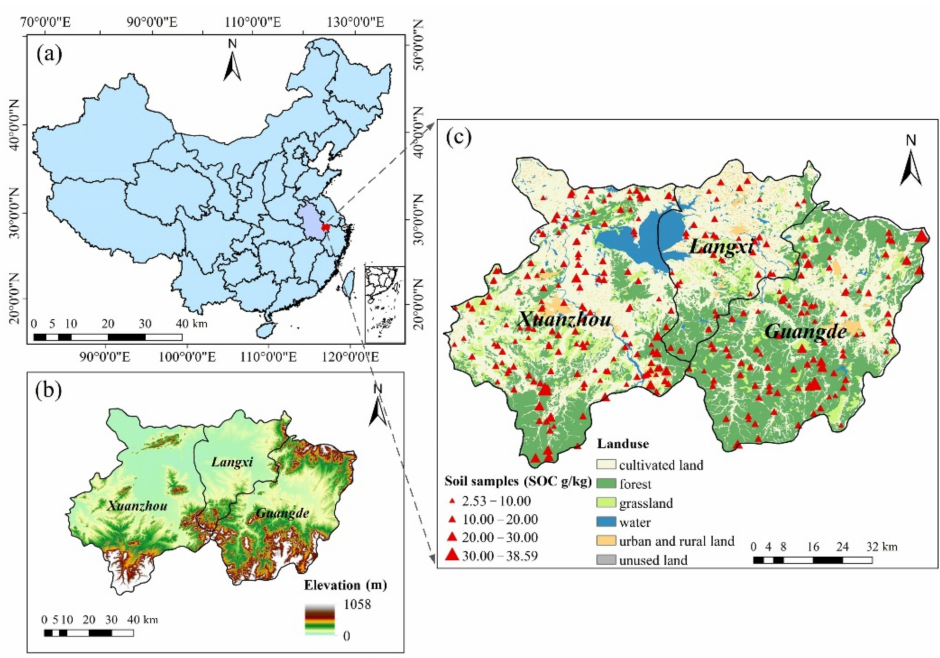
Figure 1. The location ( a ), elevation ( b ), and soil sample locations overlaid on the land cover map ( c ) of the study